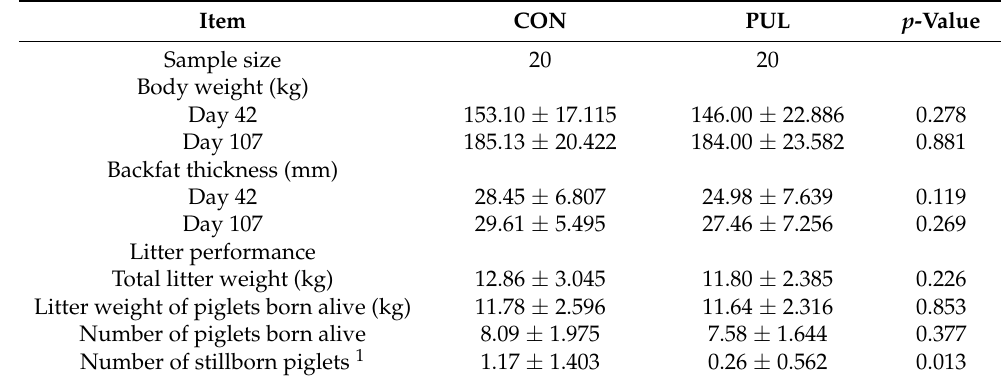
Table 3. Effects of olive pulp dietary inclusion on growth and litter performance of Iberian sows (mean ± SD).